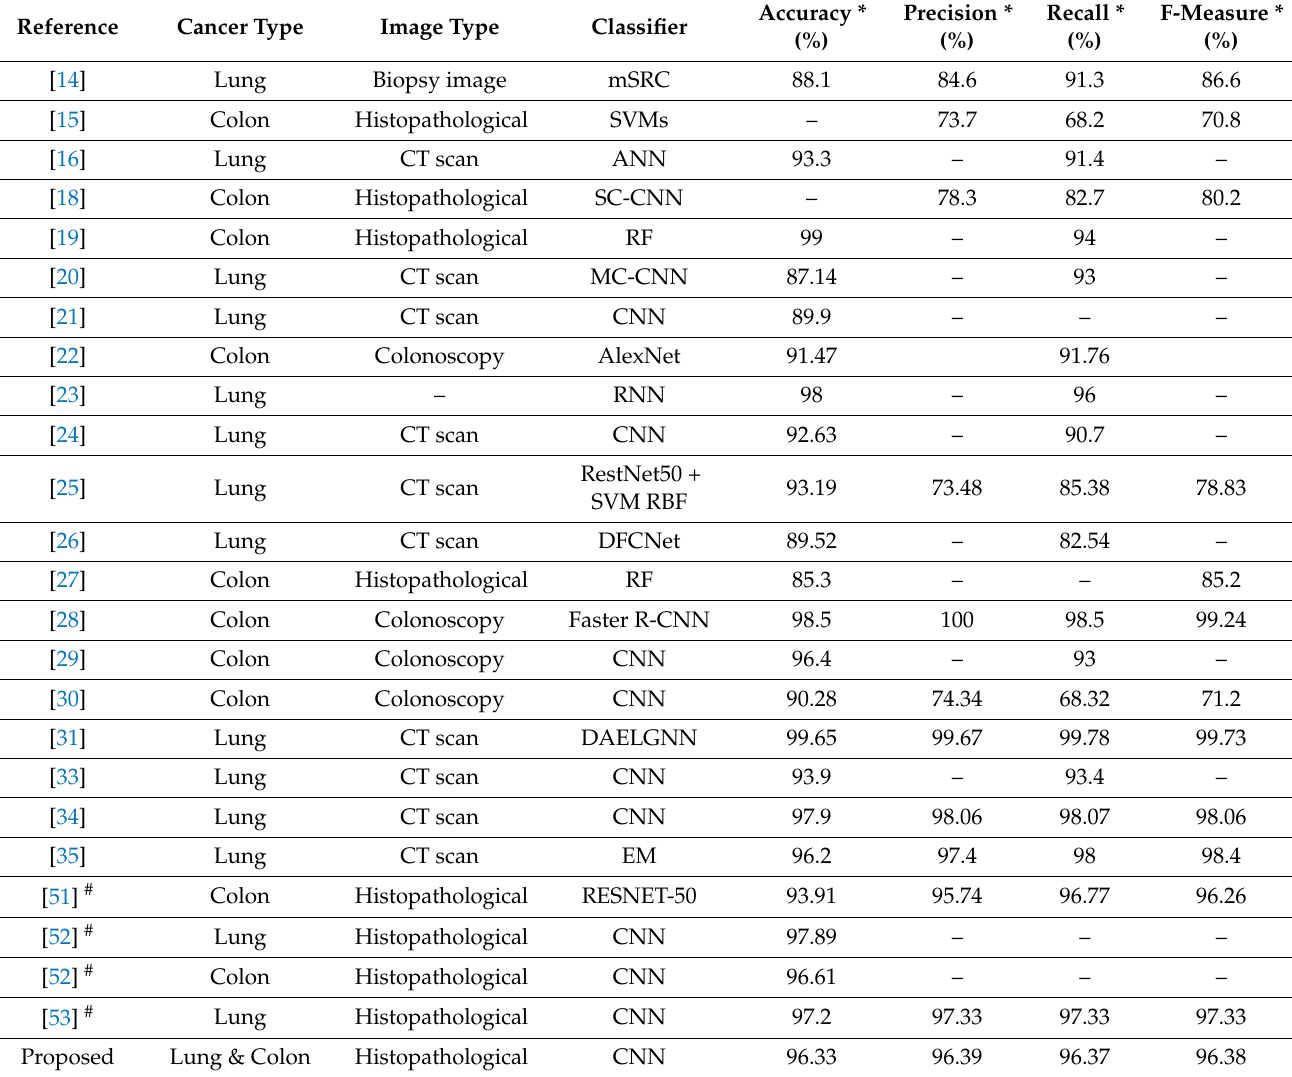
Table 3. Comparison of the acquired results with other